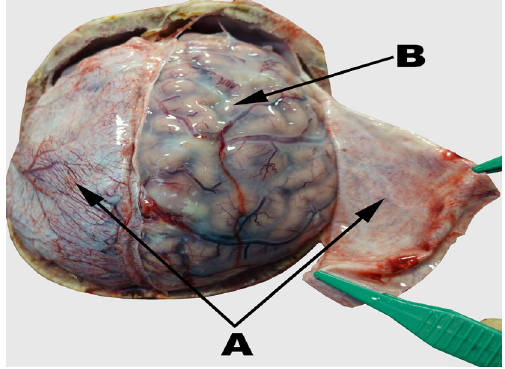
Figure 4. The meninges’ picture done during autopsy: the dura mater ( A ), and the arachnoid ( B ) mater. Table 4. Demographic characteristic of the patients’ groups enrolled in the study.